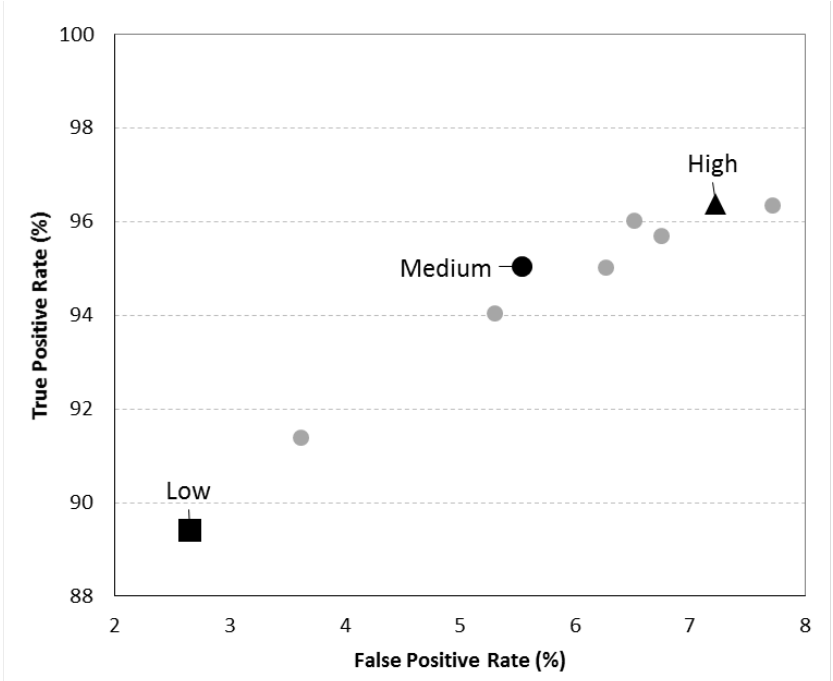
Figure 1. Receiver Operating Characteristic (ROC) curve with the 10 sets of thresholds that presented a better J-index when the algorithm was tested with the test set sampled at 100 Hz—Black square: Low sensitivity level; Black doth: Medium sensitivity level; Black triangle: High sensitivity